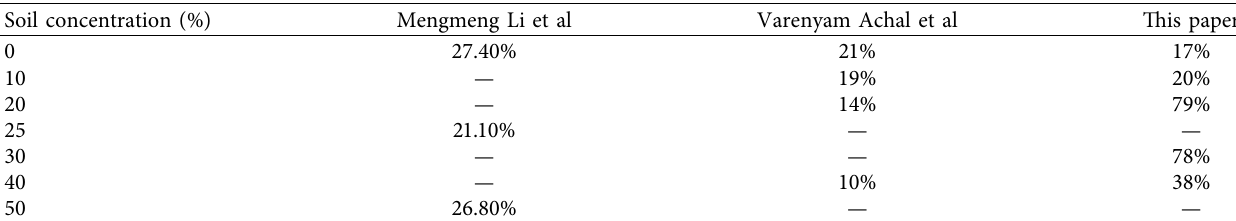
Figure S1: grading size distribution curves of bentonite (a) and cement (b) used in sample preparation. Table S1: